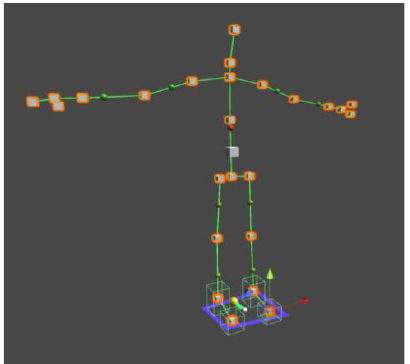
Fig. 5 Joints tracked by the MS Kinect SDK.